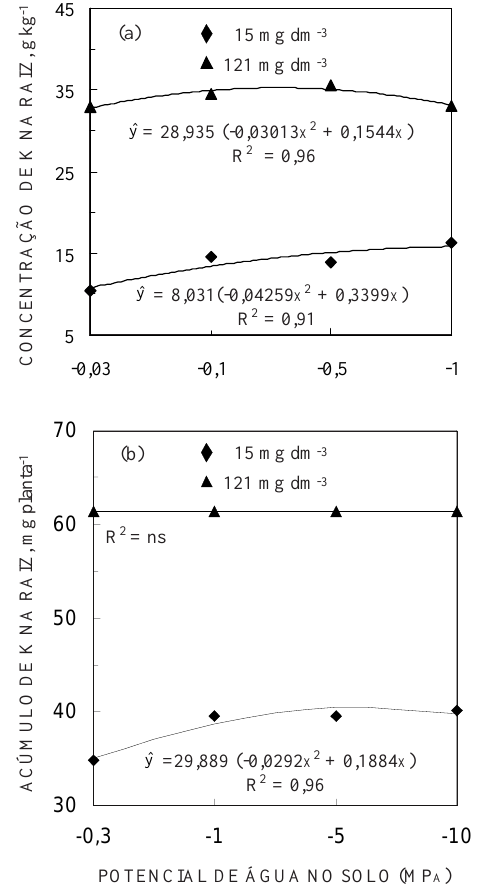
Figura 1. Concentração de potássio na matéria seca da raiz (a) e acúmulo de potássio na raiz do algodão (b), considerando o conteúdo de água no solo e a aplicação de potássio.